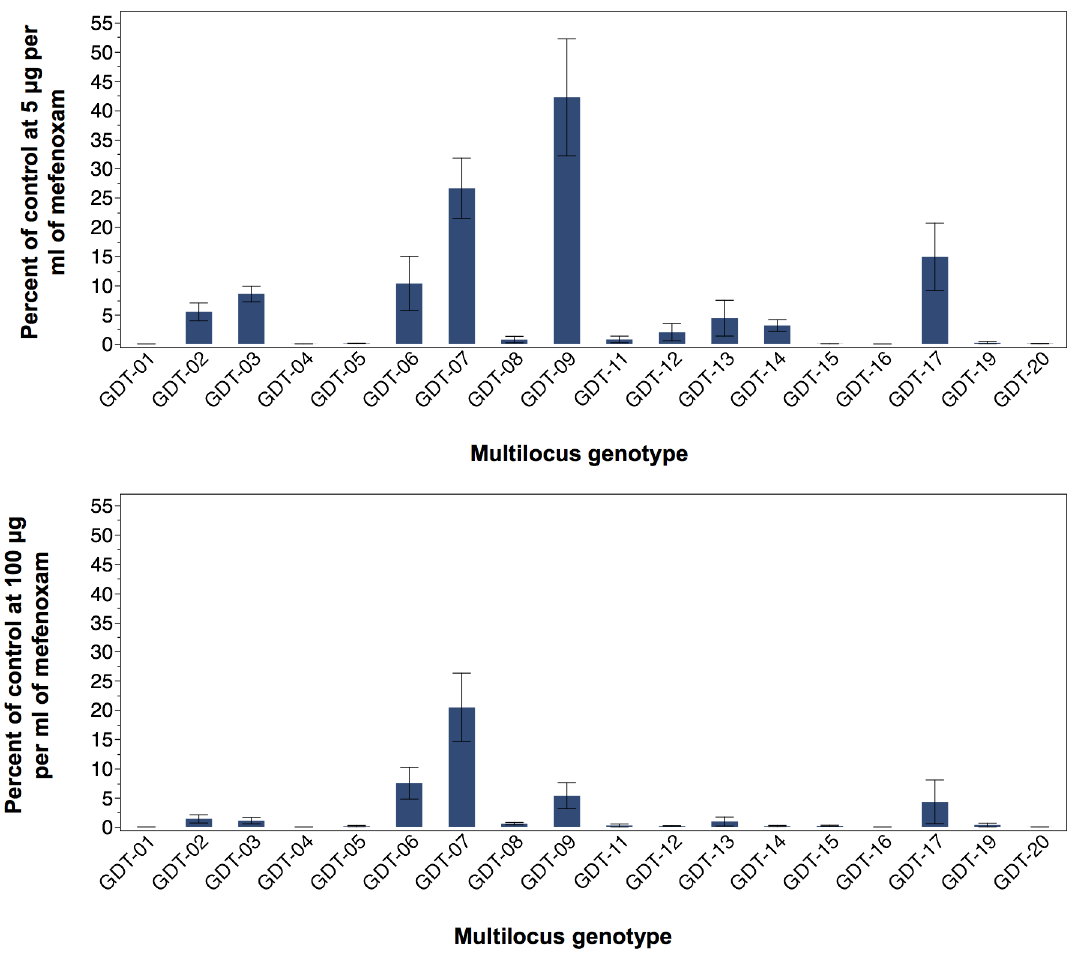
Fig. 2. Response of Phytophthora infestans isolates to mefenoxam. Relative growth (as percentage of control) at 5 m g ml 2 1 (top) and 100 m g ml 2 1 (bottom) relative to control 0 m g ml 2 1 is presented. Sample sizes for each multilocus genotype can be found in S1